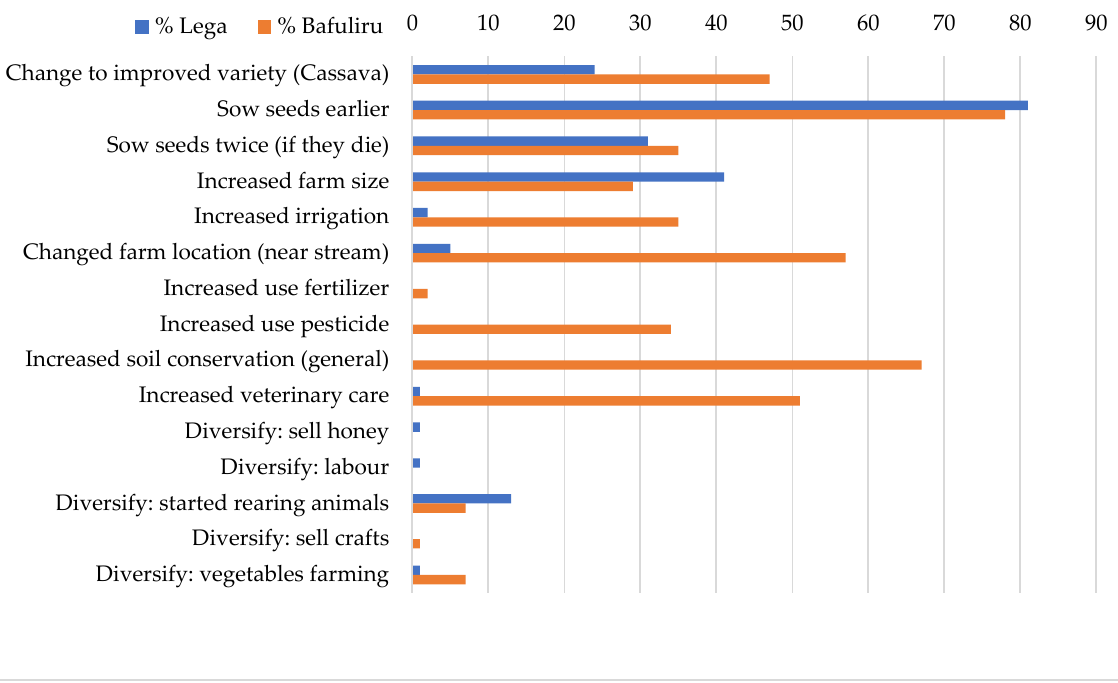
Figure 4. Adaptation strategies used per ethnic group ( n = 150 Bafuliru, n = 150 Lega). Diversion ditches are the most common soil conservation technique used by the Bafuliru.